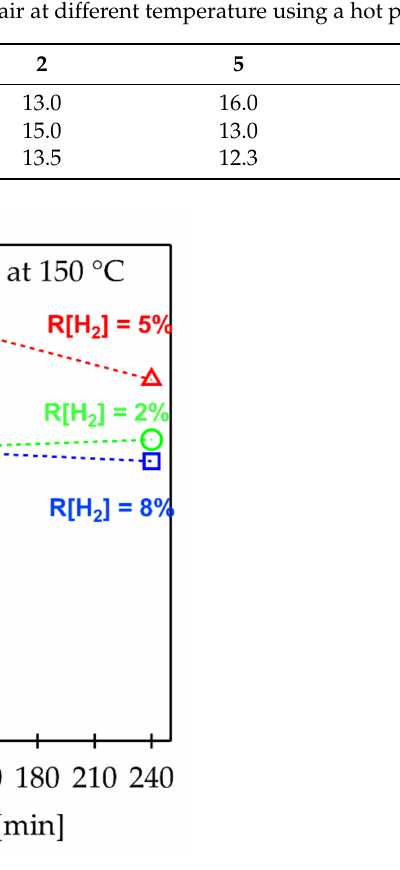
Figure A1. Annealing time dependence of the carrier density for H-doped IGZO films after 1 h annealing in N 2 at 150 ◦